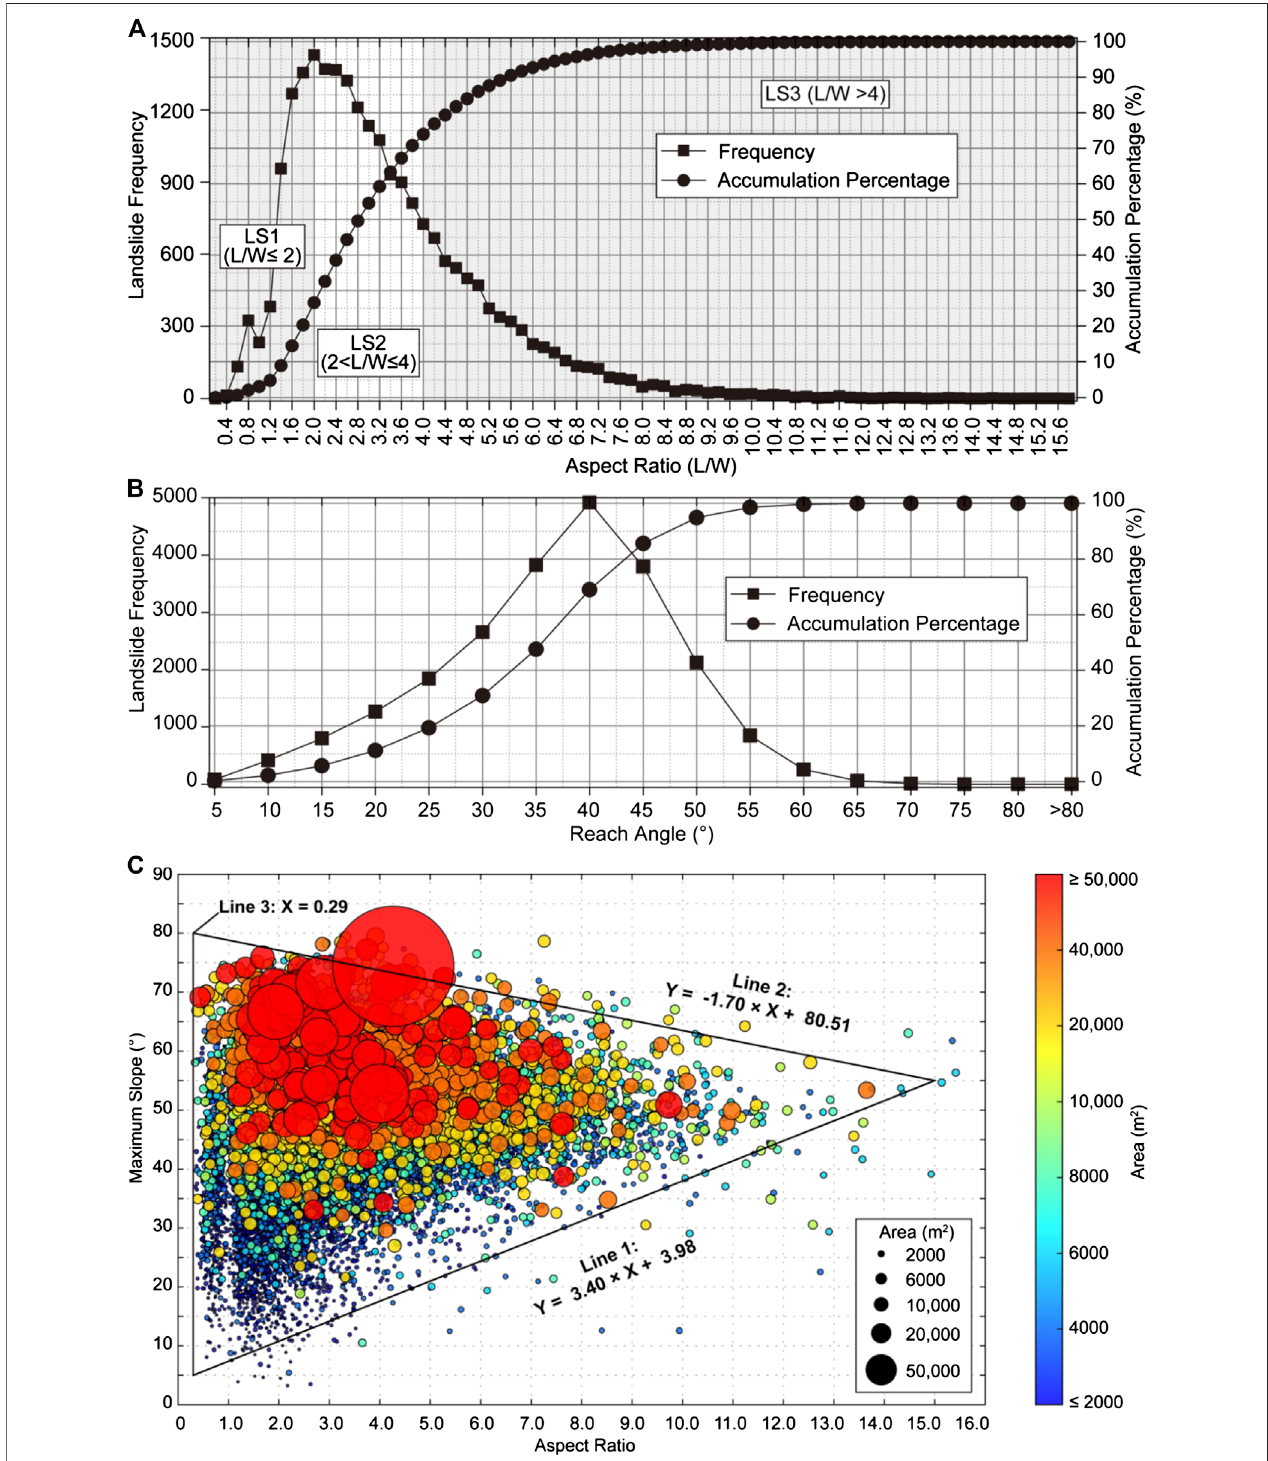
FIGURE 6 | Relationships for aspect ratio (A) and reach angle (B) vs. landslide number; and (C) for the landslide aspect ratio, maximum slope, and area.